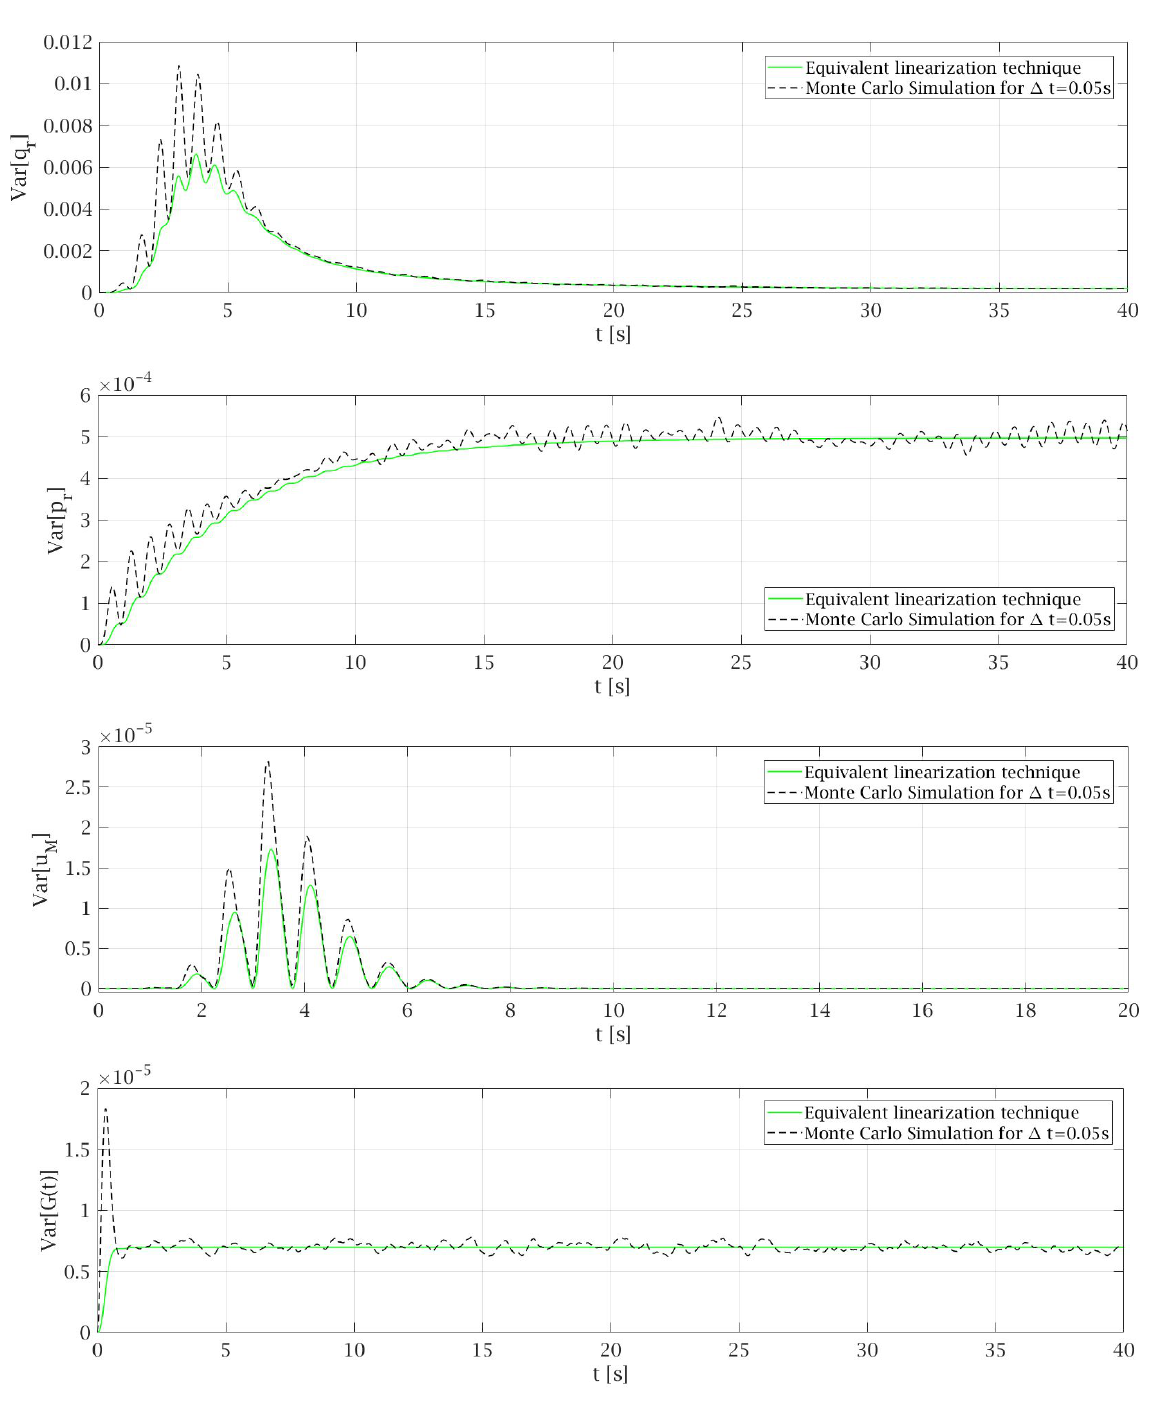
Figure 6. Comparison of the variances of selected random state variables obtained for P = 1.87 × 10 − 4 and ζ s =